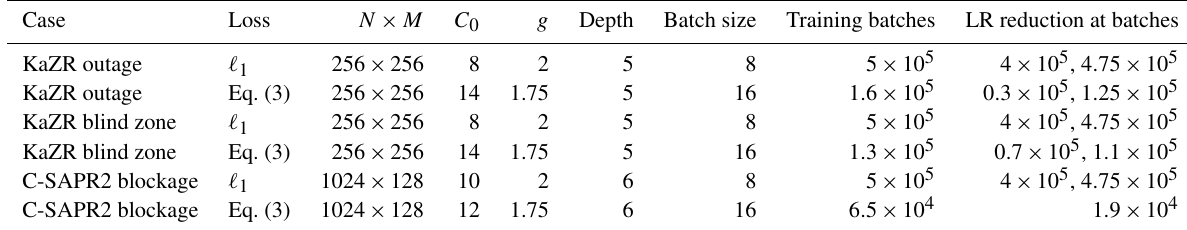
Table 1. Table of neural network hyper-parameters and training parameters. N × M , C 0 , g , and “Depth” are hyper-parameters that define the size and shape of the CNN and are shown in Fig. 1. (“Depth” refers to the number of down-sampling operations or the maximum value of (cid:96) from Fig. 1.) “Batch size”, “Training batches”, and “LR reduction at batches” refer to the number of samples per mini-batch, the total number of mini-batches/weight updates during training, and the batch number after which a learning rate reduction was performed, respectively. Case Loss N ×